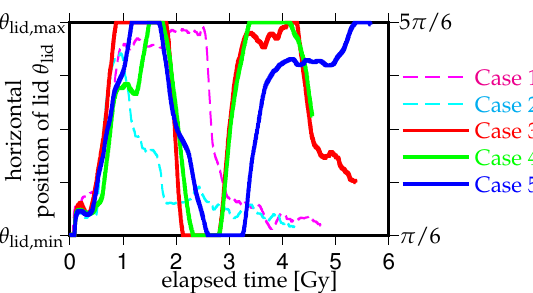
Figure 2. Plots against elapsed time of the horizontal position of the continental lid θ lid for Cases 1–5. In the figure, θ lid,min ≡ θ min + w lid /2 ( = π /6) and θ lid,max ≡ θ max − w lid /2 ( = 5 π /6) are the minimum and maximum values of θ lid , respectively.